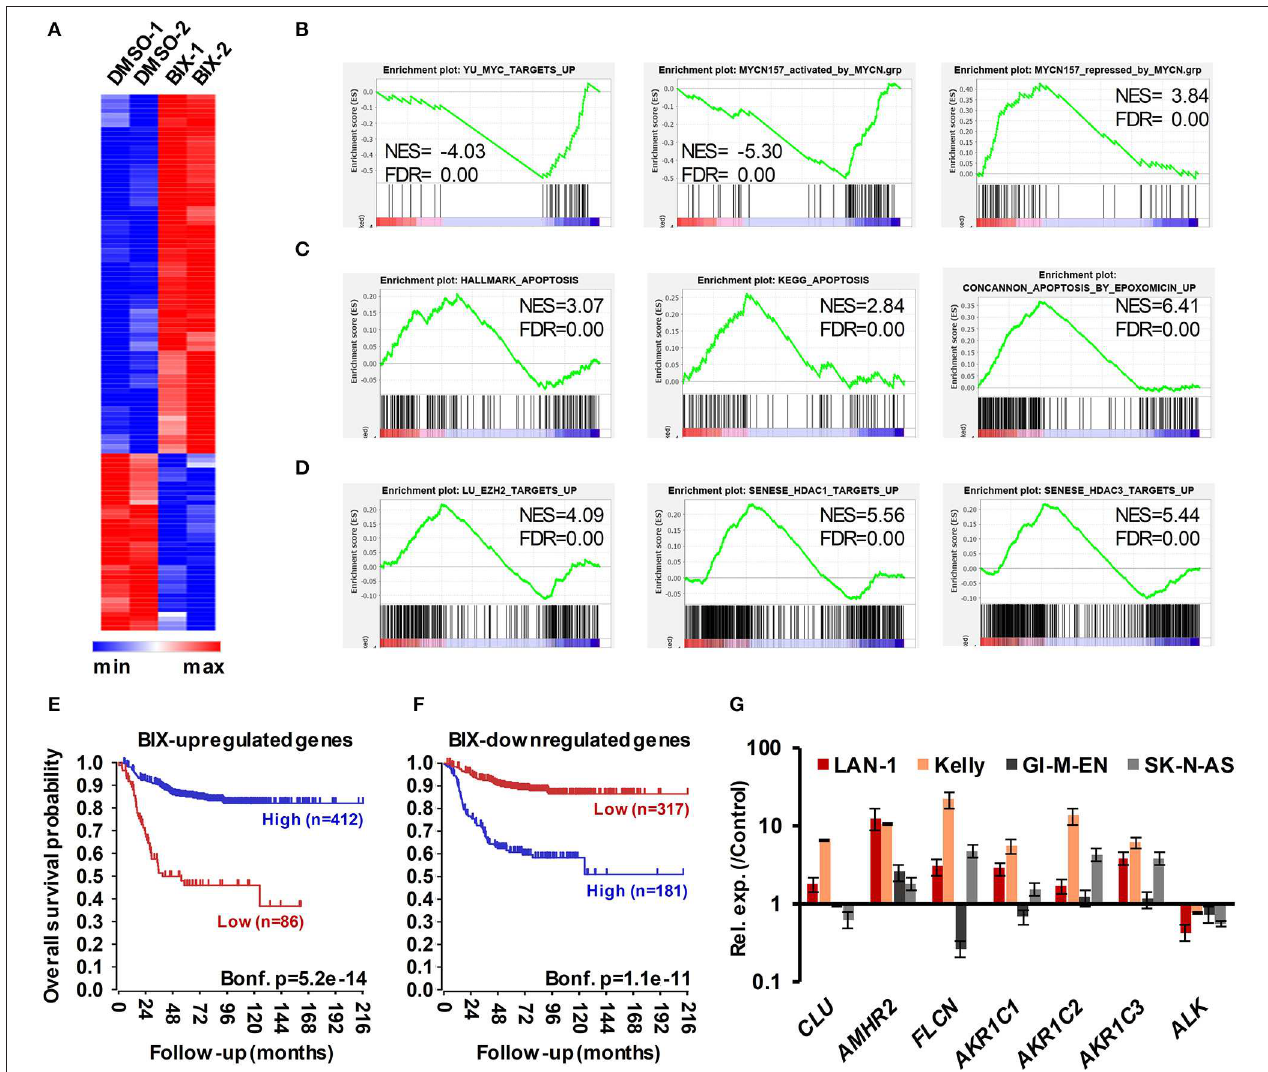
FIGURE 8 | RNA sequencing of BIX-01294 treated LAN-1 cells identifies G9a regulated genes. (A) Heatmap of differentially expressed genes (DEGs) in biological replicate treatments of LAN-1 NB cells by 3 µ M BIX-01294 for 72h, ( p < 0.005, minimum fold change 1.3). (B) Gene set enrichment analysis (GSEA) showing reversal of MYC/MYCN-driven transcriptomic changes. The MYCN-157 gene sets were derived from Valentijn et al. ( 34). (C) GSEA indicating upregulation of gene sets associated with apoptosis and (D) repression by EZH2, HDAC1 and HDAC3. (E) Kaplan–Meier survival analyses showing that high expression of genes upregulated by BIX-01294 treatment in LAN-1 correlates with good prognosis in an expression data set of 498 primary NB tumors (SEQC, GSE62564), while (F) high expression of BIX-01294 downregulated genes correlates with poor prognosis. (G) Validation of DEG in MNA NB cell lines, LAN1 and Kelly, and non-MNA cells, GI-M-EN